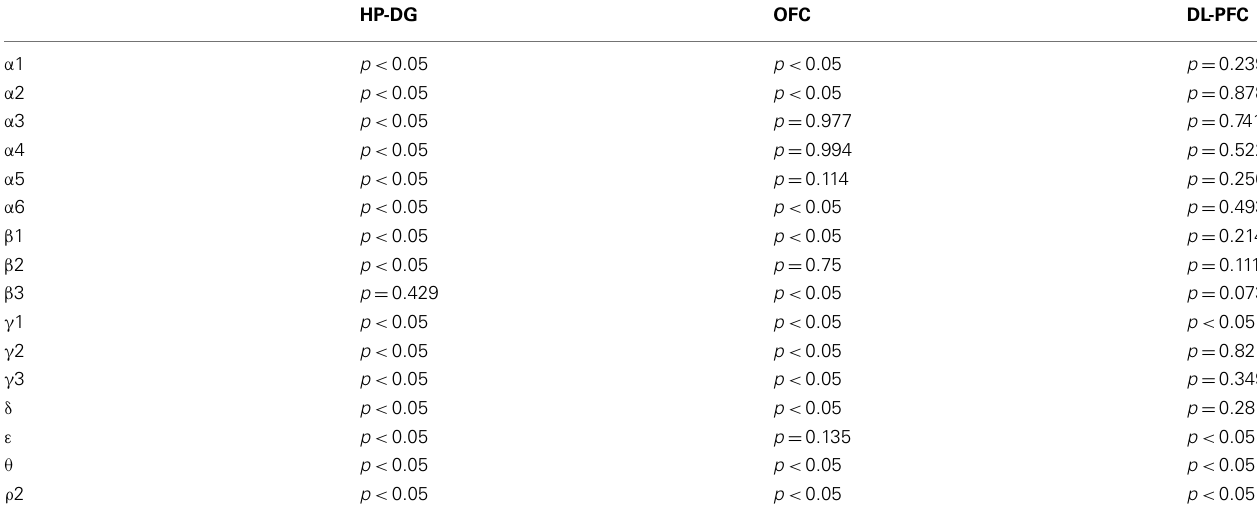
TableA3 |Analysis of normality of RT-qPCR data distribution by Shapiro–Wilk normality test ( p values are shown below). HP-DG OFC